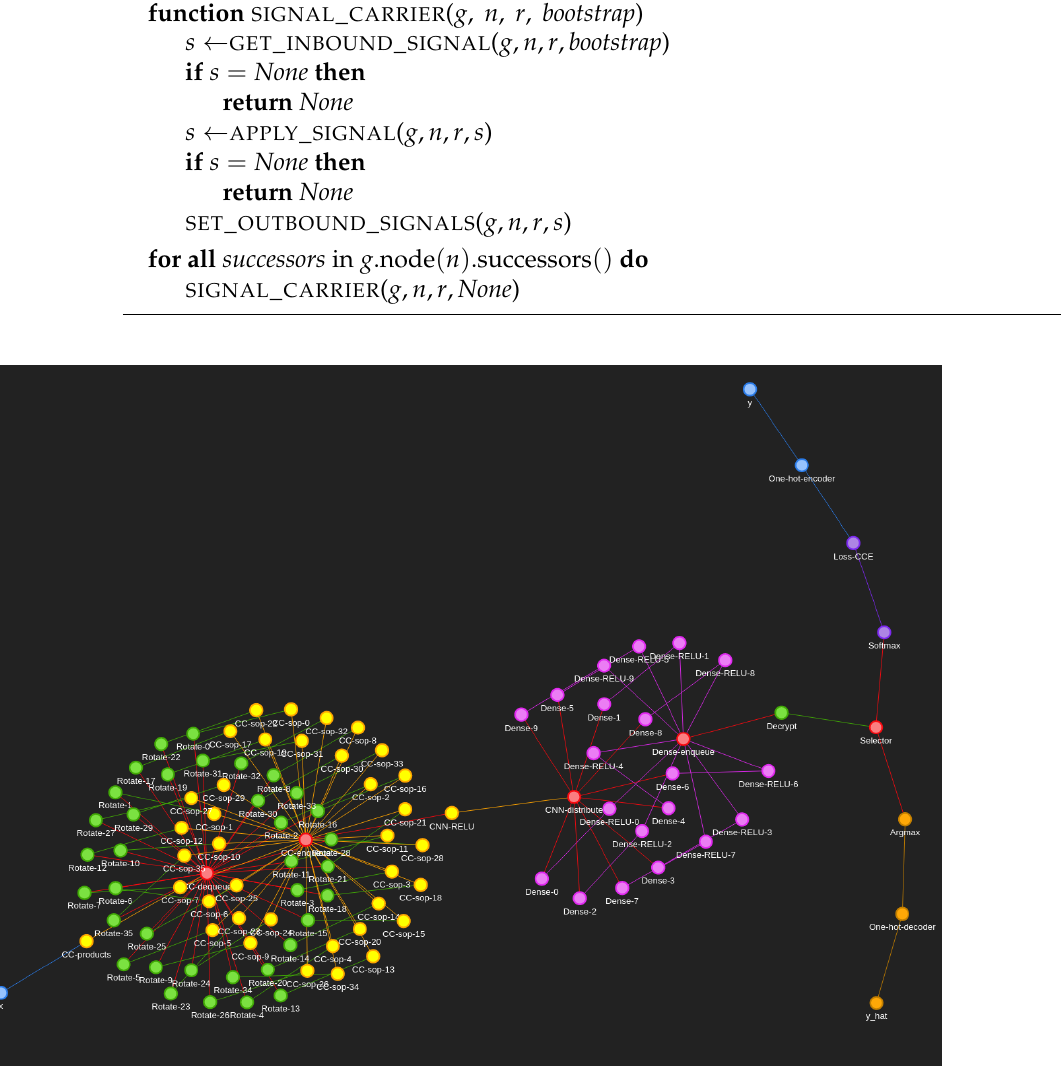
Figure 3. Fashion-MNIST computational graph we call “sphira”, showing the colour-coded graph and the respective nodes used to train/compute Fashion-MNIST using our neuronal firing algorithm. Blue represents the input and input transformation circuit that deals with passing the signals into the neural network in a way it is expecting them. Yellow represents the convolutional neural network components where one filter neuron passes multiple output cyphertexts to a plethora of summing nodes. Pink represents the fully connected dense layer for each class. Purple represents the loss calculation circuit necessary for backpropagation. Orange represents the output/prediction circuit. Red represents the generic glue operations necessary to bind components together. Green represents the encryption specific nodes such as decryption, rotation, and encryption. An interactive version of this graph is available in our source code documentation so that clusters of nodes can be peeled apart for investigating individual nodes and connections